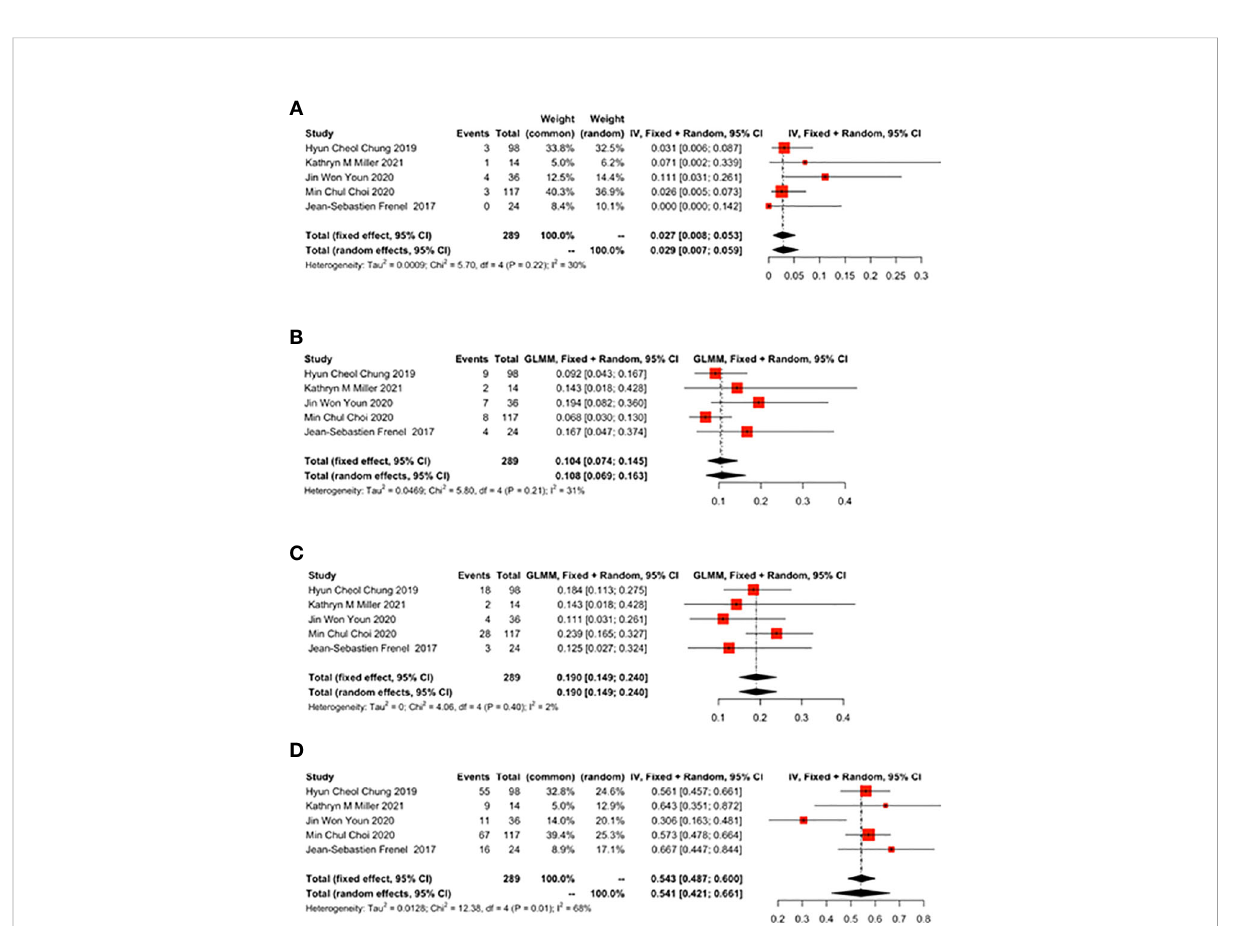
FIGURE 2 Complete response (CR), partial response (PR), stable disease (SD), disease progression (PD) for patients with cervical cancer receiving pembrolizumab therapy. (A) CR, (B) PR, (C) SD, (D)